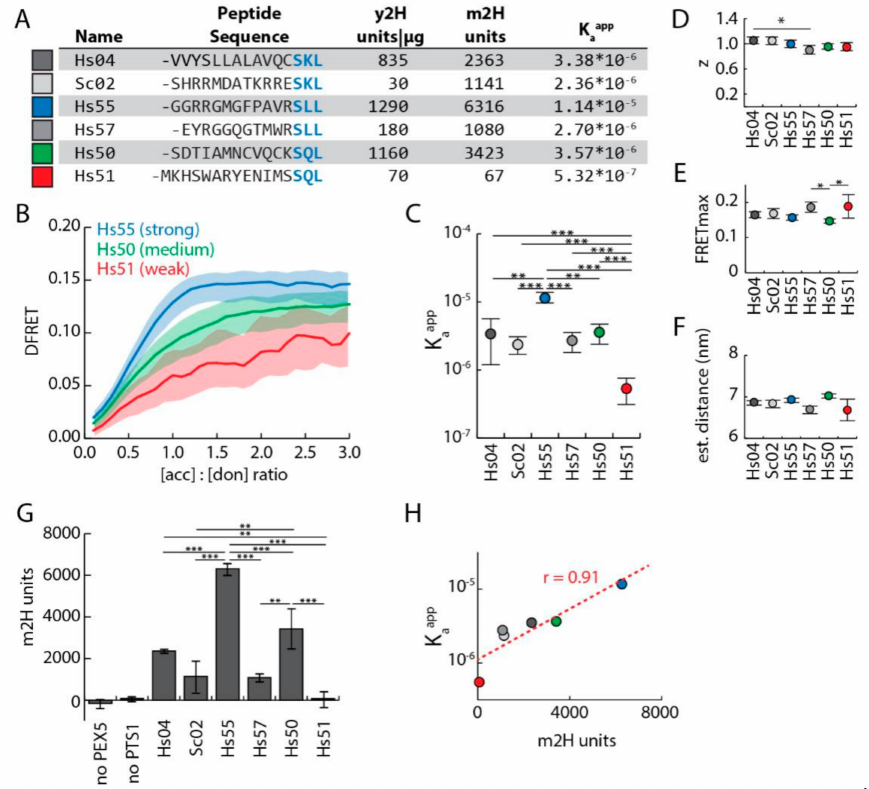
Figure 3. A ffi nities of PEX5 for di ff erent PTS1 variants can be discriminated by FlowFRET: ( A ) Table of six di ff erent PTS1 peptides investigated, together with the apparent interaction strength measured by a yeast 2H assay (y2H [12]), by the mammalian 2H assay (m2H, cf. Figure 3F) and by FlowFRET (K aapp ); ( B ) di ff erent curve progression for strong, intermediate and weak PTS1: FlowFRET measurements of pex5 − / − cells expressing mCherry-PEX5 TPR together with one of the six EGFP-PTS1 variants are represented by saturation curves for PTS1 peptides with a high (Hs55, blue), intermediate (Hs50, green) or low (H51, red) a ffi nity to PEX5 TPR ; ( C – E ) independent fittings of data sets resulted in markedly di ff erent predictions for the K aapp , but very similar ones for the stoichiometry factor (z) and the plateau level of the saturation curve (FRET max ) ( n = 3, mean ± standard deviation (sdv)). ( F ) The estimated distance between mCherry and the di ff erent EGFP proteins was calculated from FRET max values. ( G ) m2H: normalized luciferase activity of pex5 − / − cells expressing PEX5 TPR behind the activation domain of the Herpes-Simplex-Virus protein-16 (VP16 AD -PEX5 TPR ) and EGFP-PTS1 variants fused to the DNA-binding domain of the yeast Gal4p protein (GAL4 DBD -EGFP-PTS1) each terminating with the peptide described above or controls expressing VP16 AD - or GAL4 DBD - fusion proteins alone is presented ( n = 3, mean ± sdv); ( H ) correlation of the results of FlowFRET (K aapp ) and the apparent interaction strength obtained by the m2H in pex5 - / - cells. Statistics: One-way ANOVA for log10 of K aapp ( C ), z ( D ) and FRET max ( E ), (( C – F ): three independent experiments’ mean ± sdv). *** p < 0.001, ** p < 0.01, * p < 0.05, Description: ( B ) Lines represent moving average, shaded area represents the upper and lower